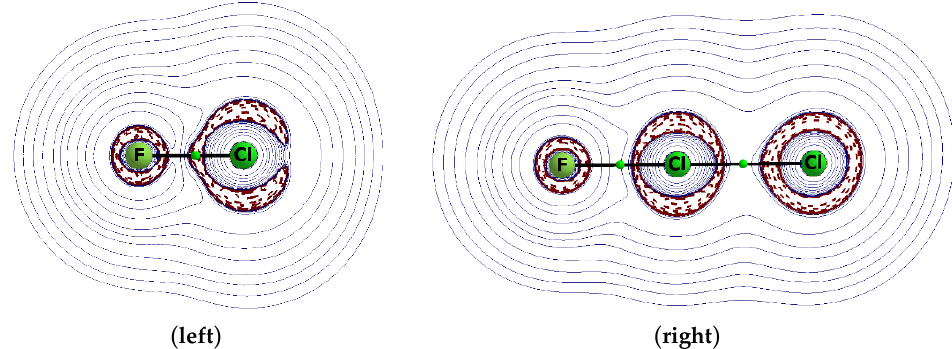
Figure 2. Maps of the Laplacian of the electron density for the F – Cl species ( left ) and for its complex, FCl∙∙∙Cl − ( right ). The areas of negative Laplacian values are designated by the broken brown lines.